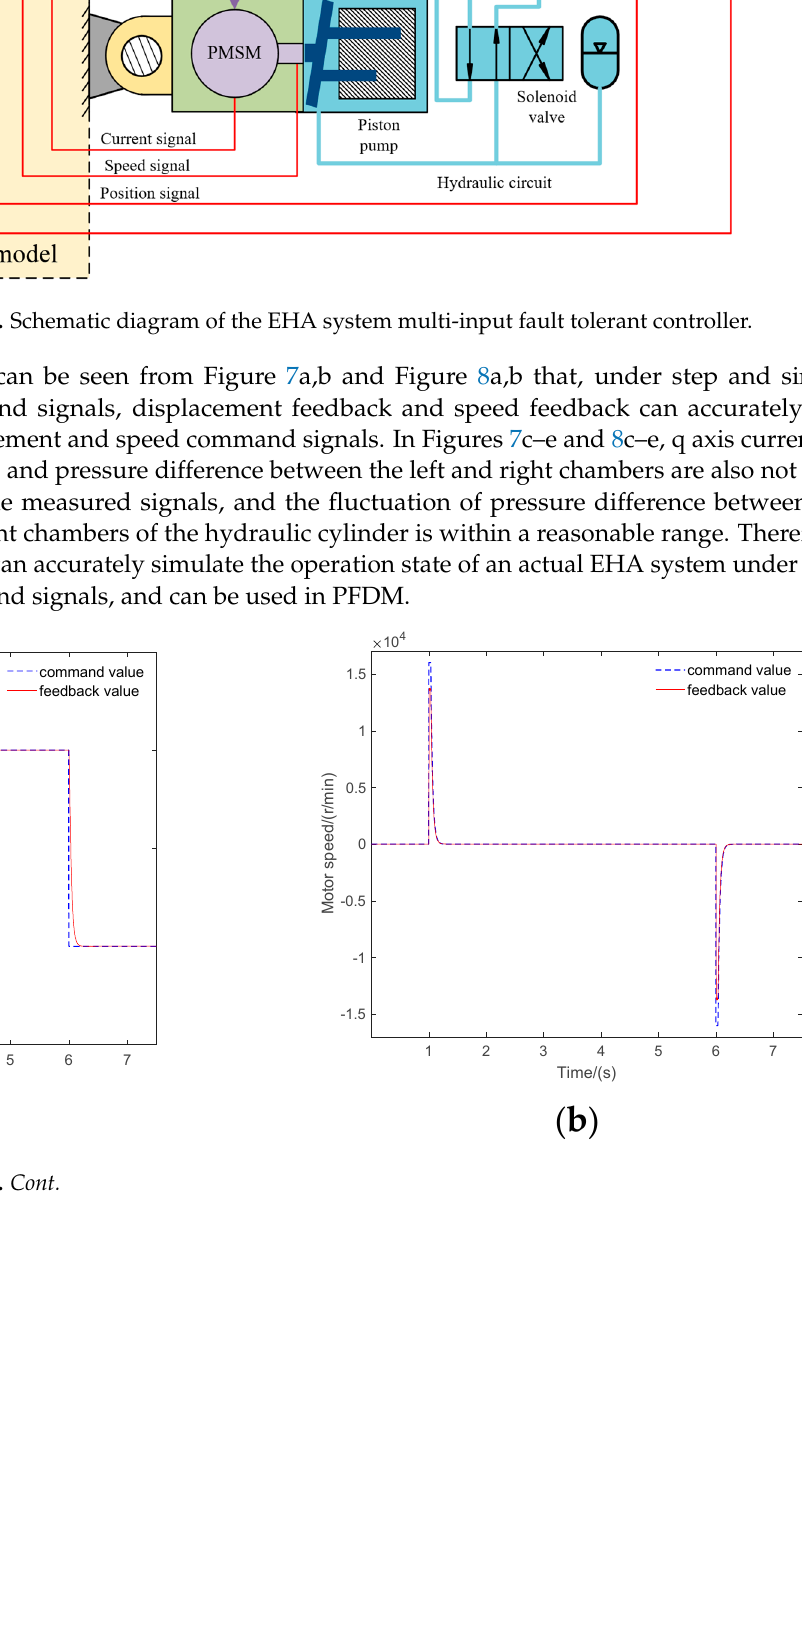
Figure 6. Schematic diagram of the EHA system multi-input fault tolerant controller .